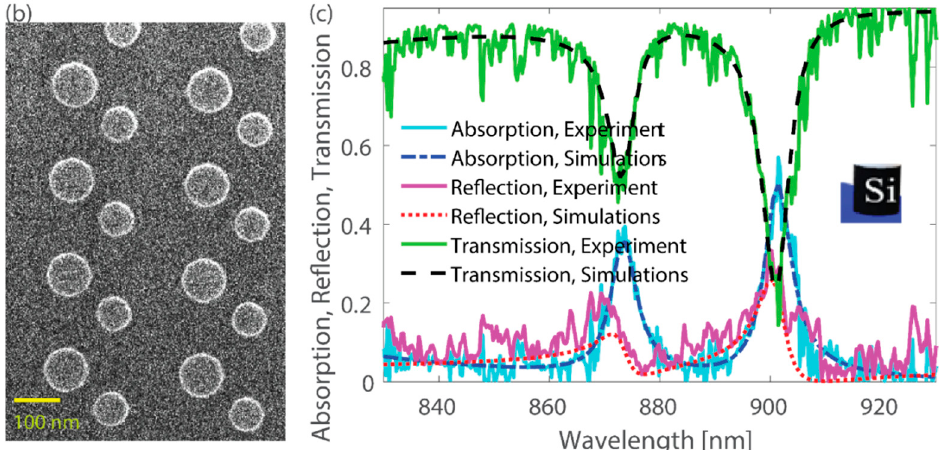
Figure 3. Multiple mode excitations and generalized Kerker effect. ( a ) Absorption, reflection, and transmission for a binary array of the hybrid metasurface. The nanodisks are of height H = 120 nm and radii R 1 = 50 nm and R 2 = 30 nm, and the pairs are arranged in the periodic array with periods P x = P y = P = 550 nm. The two green circles highlight regions where the generalized Kerker effect is observed (suppressed reflection due to scattering compensation between multiple resonances). Inset: Changes in the reflection spectra when the surrounding refractive index is increased by 0.02. The dot-dash black lines indicate the absolute change, while the solid red and dashed magenta lines show the re fl ection scaled by 0.25 for visual clarity. Notably, the largest absolute change in re fl ection occurs at spectral points corresponding to the generalized Kerker e ff ect, with values reaching up to 0.2. ( b ) Scanning electron microscope image of binary silicon array. ( c ) Absorption, re fl ection, and transmission for a binary silicon array with one layer of silicon nanodisks of height H = 140 nm and radii R 1 = 100 nm and R 2 = 70 nm, and the pairs are arranged in the periodic array with periods P x = 550 nm and P y = 380 nm. Insets: Schematics of the elements constituting the metasurface (hybrid in ( a ) and silicon in ( c )).